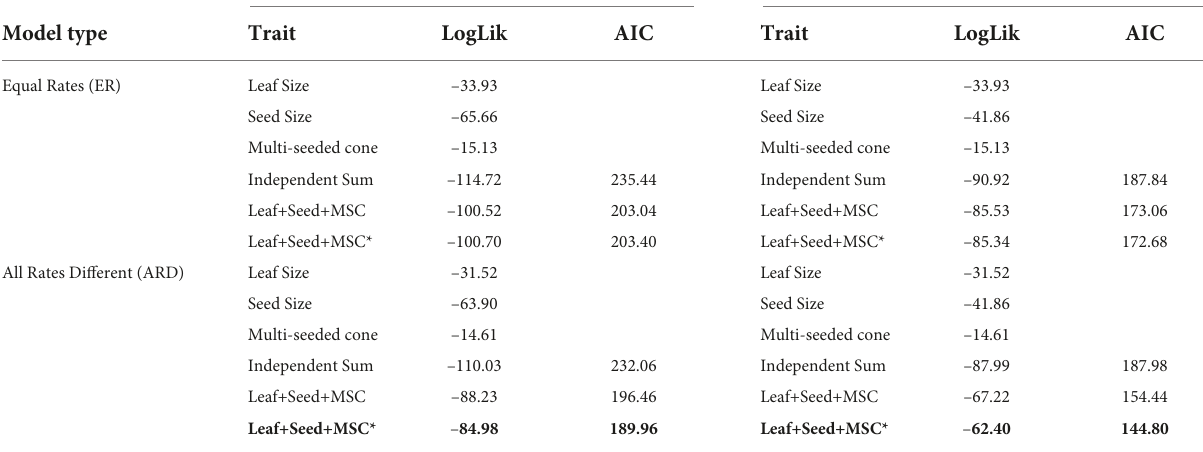
TABLE 1 Comparison of trait evolution